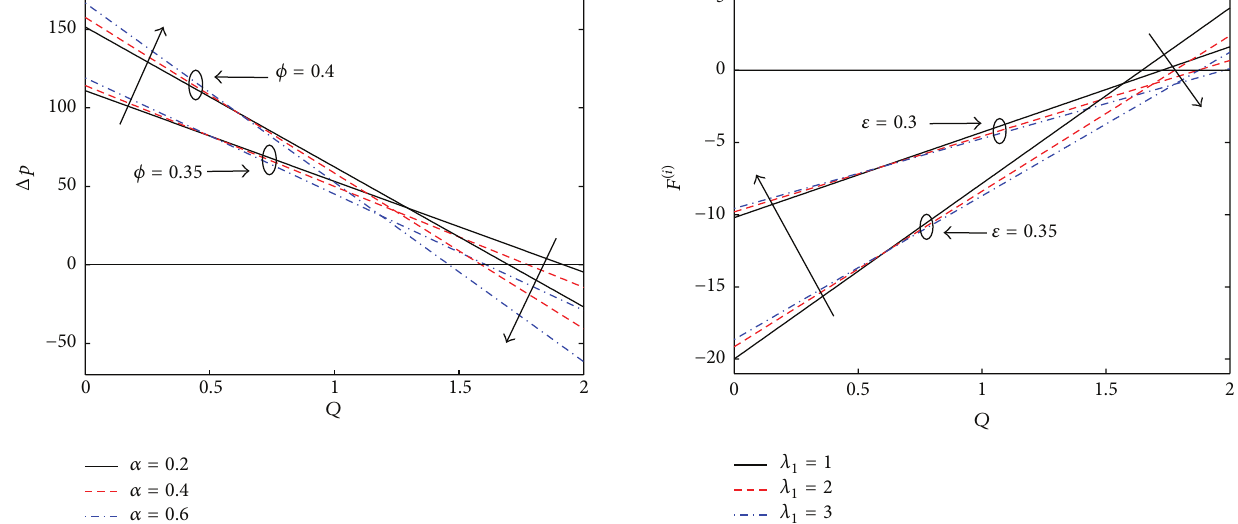
Figure 9: Frictional force on the inner tube 𝐹 (𝑖) versus the time- averaged flow rate 𝑄 for different values of the relaxation time 𝜆 1 and radius ratio 𝜀 with Gr = 3 , 𝛼 1 = 0.4 , 𝛽 = 10 , 𝜙 = 0.4 , and 𝑡 = 1 .